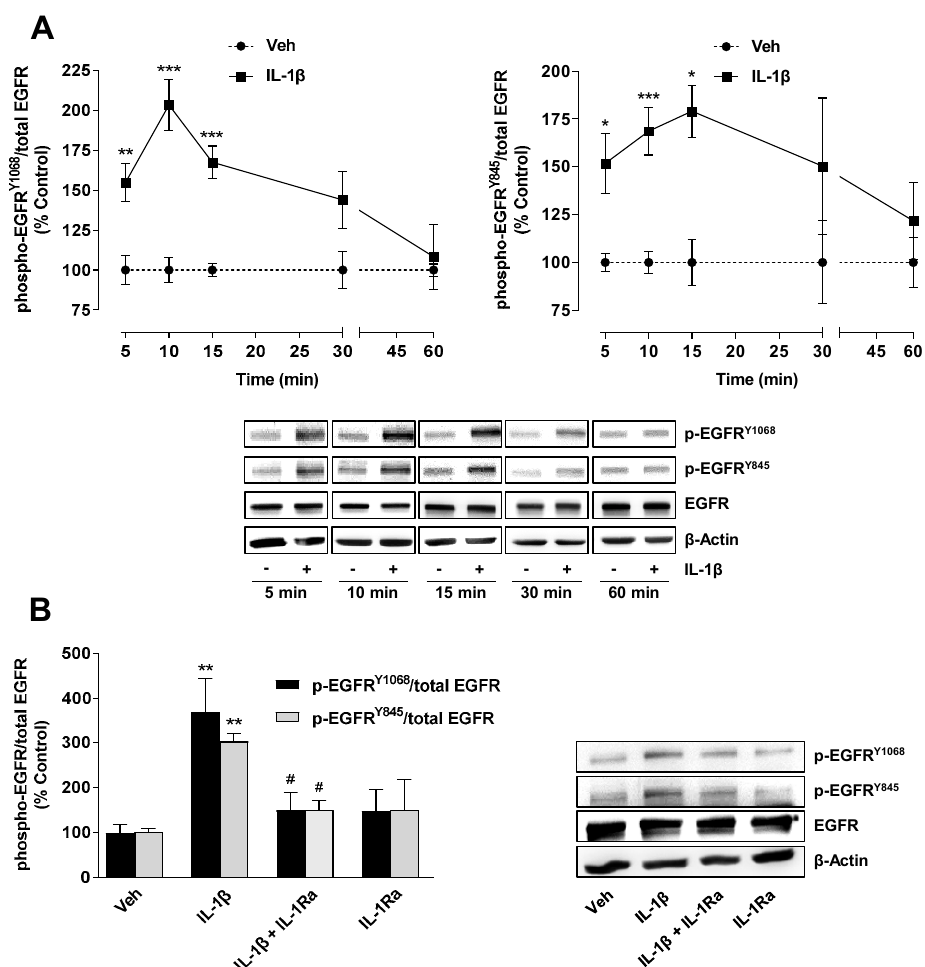
Figure 3. TF expression induced by IL-1 β is mediated by an IL-1 receptor-dependent activation of EGFR. Time course of IL-1 β -induced EGFR activation at Tyr1068 and Tyr845 ( A ). Effect of IL-1Ra (10 µ g/mL) on IL-1 β -induced or basal EGFR activation at Tyr1068 and Tyr845 ( B ). The cells were incubated in the presence or absence of IL-1 β (10 ng/mL) for the indicated time periods ( A ) or preincubated with IL-1Ra for 2 h and then coincubated with IL-1 β for 10 min ( B ). All percentage values shown refer to the respective vehicle control, which was set to 100%. The values shown in the graphs are based on densitometric analyses of blots, whereby the phosphorylated forms were normalized to the respective total form. In the labelling of the EGFR blots ( A , B ) and in the legend of the histogram ( B ), the prefix “p-” stands for “phospho-”. The blots shown are representative. The data are mean values ± SEM of n = 3–10 ( A , left), n = 3–7 ( A , right) or n = 4 ( B ) experiments per group. * p ≤ 0.05, ** p ≤ 0.01, *** p ≤ 0.001 vs. corresponding vehicle control; # p ≤ 0.05 vs. IL-1 β ; Student’s t test ( A ) or one-way ANOVA with Bonferroni’s post hoc test ( B ). Subsequent experiments were performed with the EGFR tyrosine kinase inhibitor (TKI) erlotinib. The efficiency of erlotinib as an EGFR inhibitor in our system was confirmed by Western blot analyses, which showed complete inhibition of IL-1 β -induced EGFR phosphorylation by erlotinib (Figure 4A). Erlotinib showed a significant, albeit partial, inhibition of IL-1 β -induced TF expression at the mRNA (Figure 4B) and protein level (Figure 4C). To exclude off-target effects, two further EGFR TKIs, gefitinib (Figure 4D) and afatinib (Figure 4E), were tested, which also proved to be inhibitors of IL-1 β -induced TF expression. In the case of afatinib, the inhibitory effect on TF expression appeared to reach a plateau above a concentration of 3 µ M. For the three EGFR TKIs tested, no significant cytotoxic effect could be detected within the incubation time of 6 h